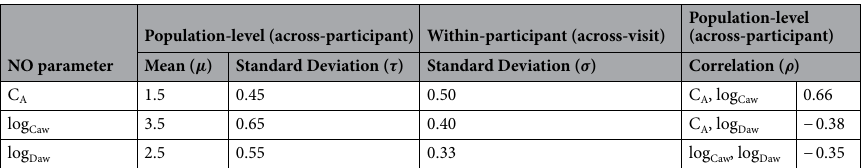
Table 1. Parameter values used to generate data in the simulation study.